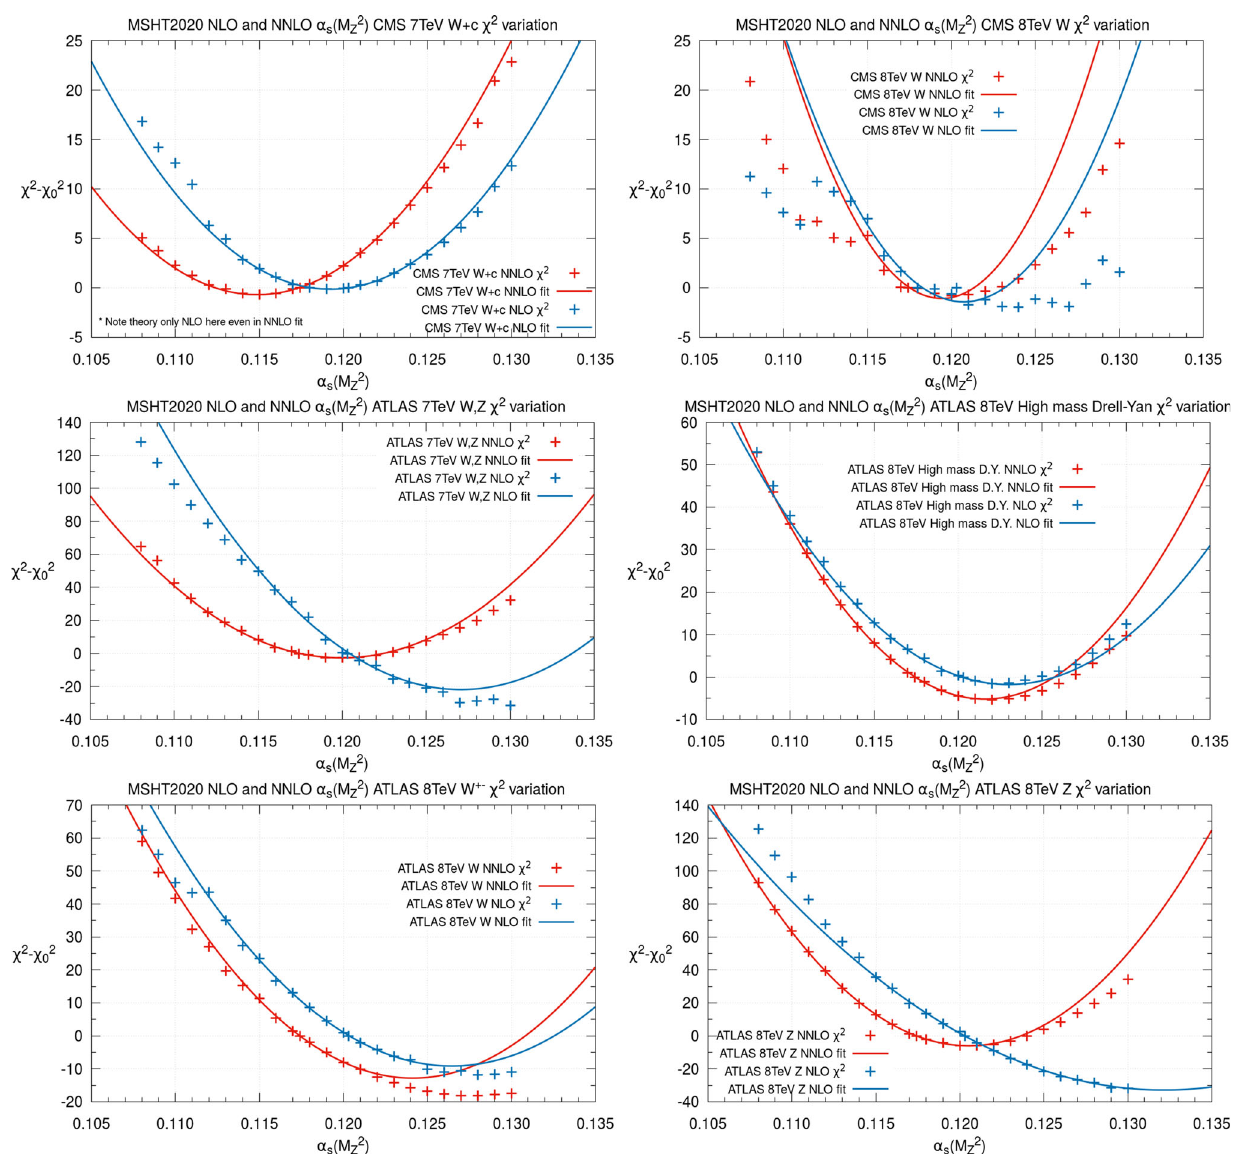
Fig. 5 Difference in the χ 2 relative to the χ 2 ) , as a function of the value of α best fit α S ( M 2 Z (blue) and NNLO (red) MSHT20 fits, respectively. The points are the results of the fits at a variety of fixed α S ( M 2